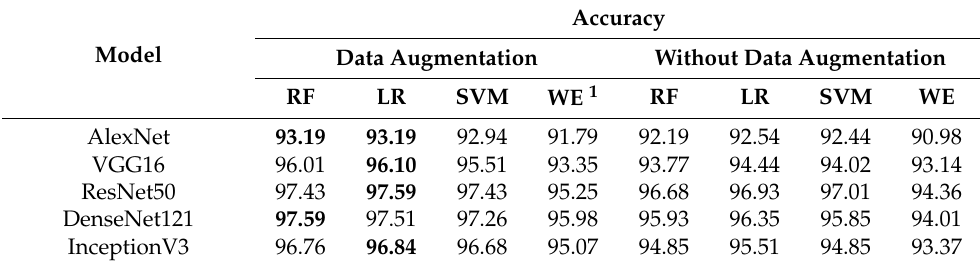
Table 3. Accuracy of the model ensemble with and without data augmentation.